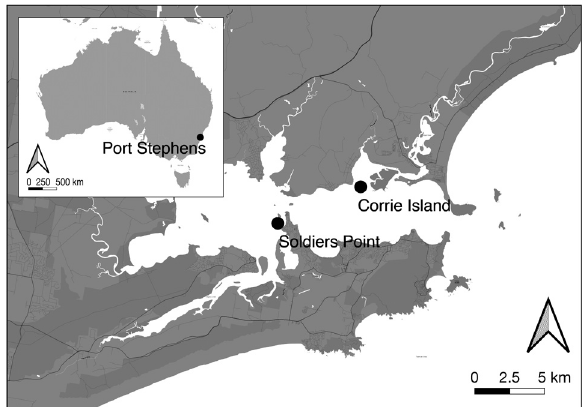
Fig. 1. Sampling sites in Port Stephens estuary, New South Wales, Australia